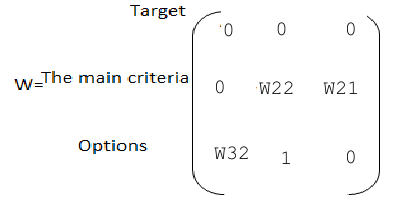
Fig. 3. Primary (unbalanced) structure of the super matrix [42].